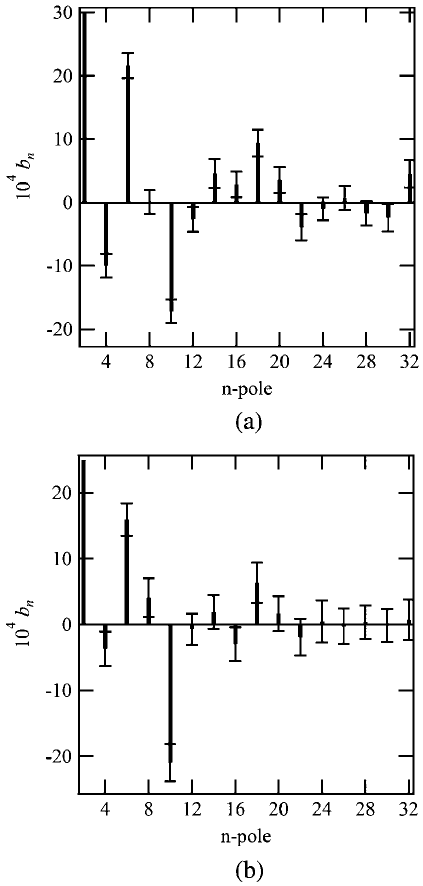
FIG. 11. Measured normal multipole content of a dipole mag- net: (a) circular trajectory; (b) 2PCT. The dipole component has been normalized to one.